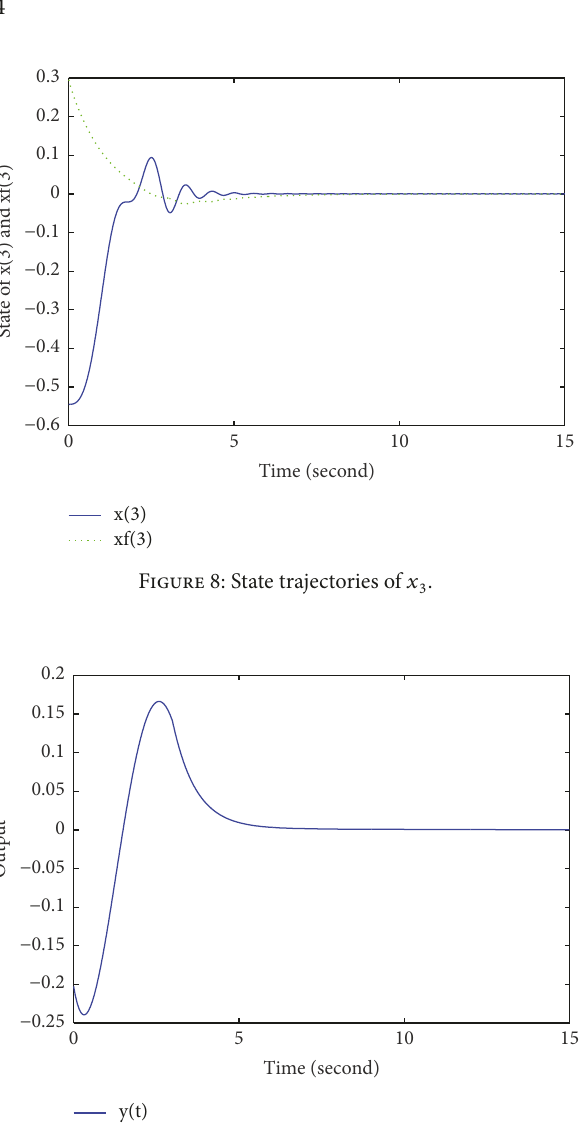
Figure 9: The trajectories of 𝑦(𝑡) .